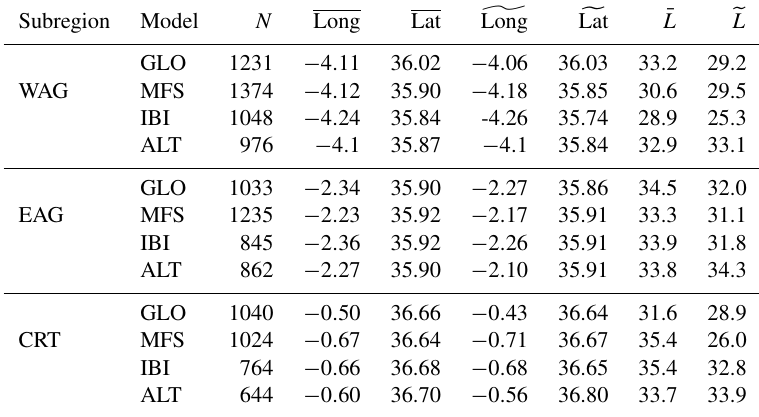
Table 2. Subregional eddy counts, and mean and median coordinates and properties from the eddy tracker for anticyclones in the Western Alboran Gyre (WAG), Eastern Alboran Gyre (EAG) and Cartagena frontal region (CRT). · and e · denote the respective means and medians of eddy positional coordinates (degrees) and radii (km) in each subregion defined in Fig. 1.